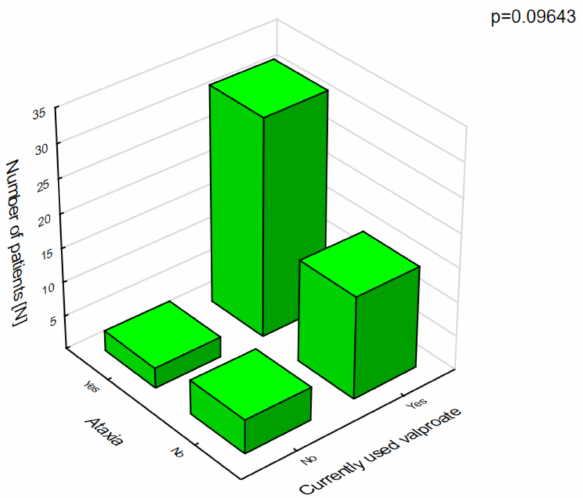
Figure 4. Valproic acid and